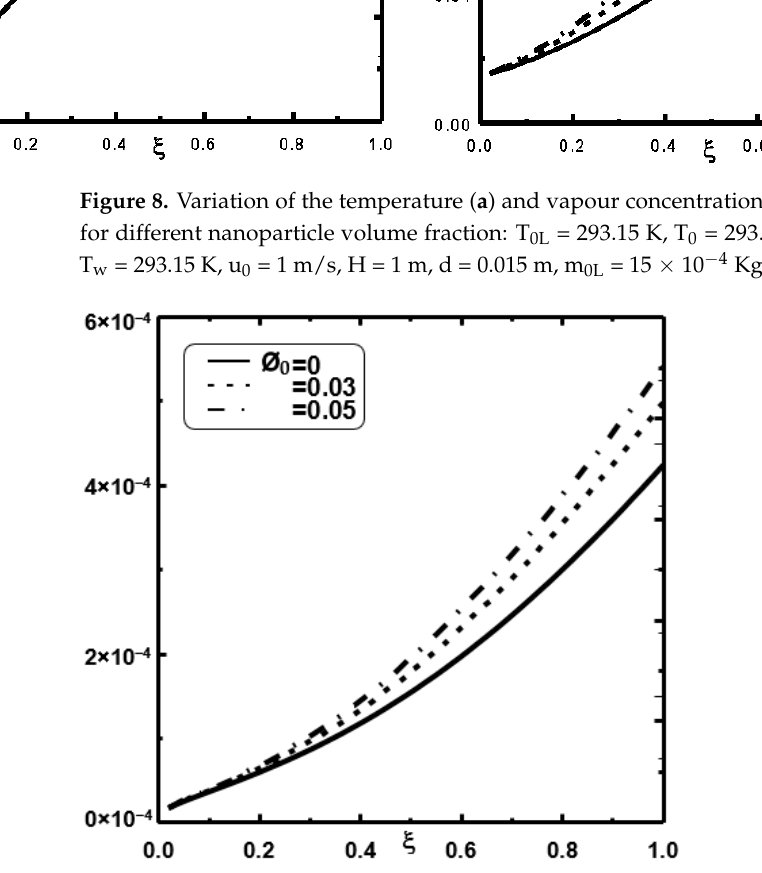
Figure 9. Effect of nanoparticle volume fraction on the total evaporation rate: T 0L = 293.15 K, T 0 = 293.15 K, q 1 = 3000 W/m 2 , c 0 = 0, T w = 293.15 K, m 0L = 15 × 10 − 4 Kg/m · s, u 0 = 1 m/s, H = 1 m, d = 0.015 m, p 0 = 1 atm.